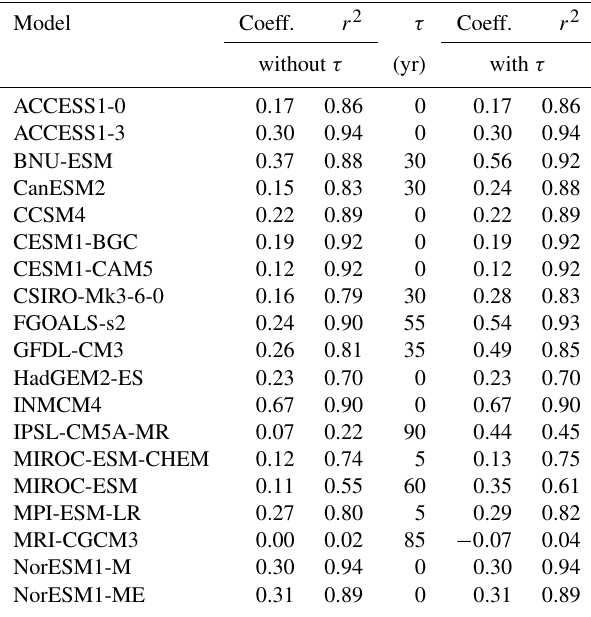
Table 3. Ross Sea sector: scaling coefficients, α r , and time delay, τ r , between increases in global mean temperature and subsurface ocean temperature anomalies.